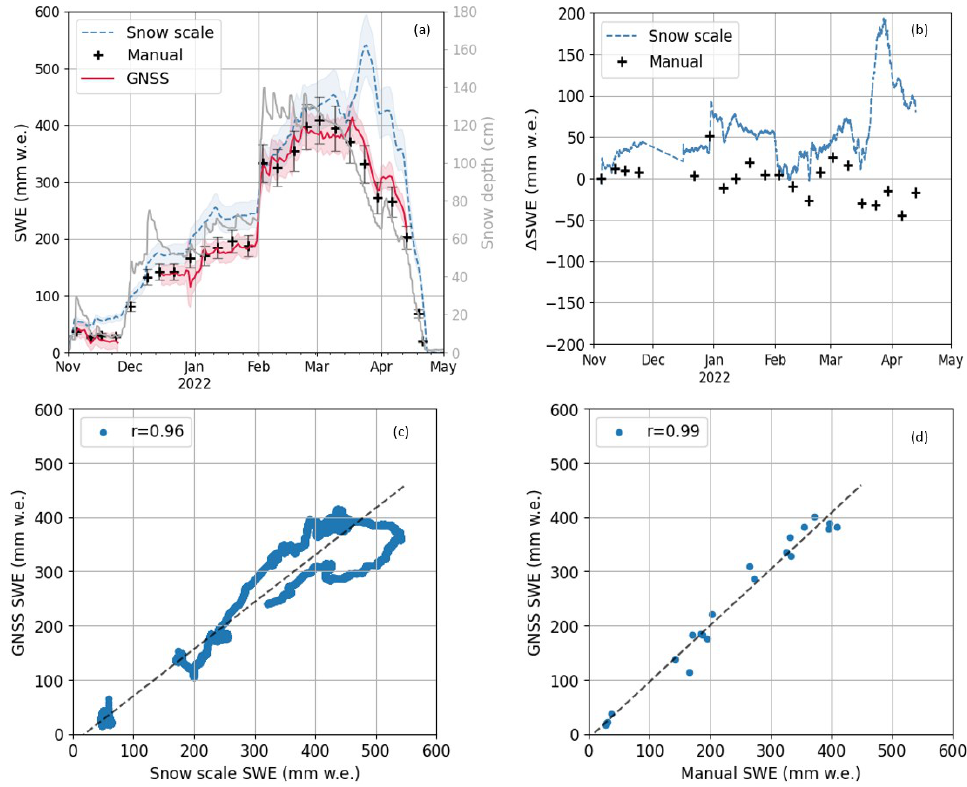
Figure 5. ( a ) Near real-time processed SWE overlaid with its standard deviation per day from the fixed, low-cost GNSS snow monitoring setup at Davos Laret for 2021/22. A relative bias of 10% is added to the snow scale and manual observations. Daily snow depth is given in grey: ( b ) differences to reference sensors observations; correlation with ( c ) the snow scale; and ( d ) manual